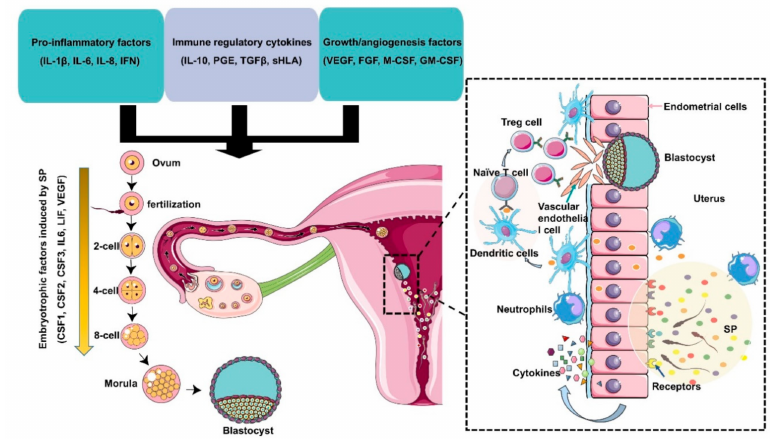
Figure 2. Immunomodulation of SP factors in the maternal reproductive tract to facilitate early embryo development and implantation. Seminal plasma contains chemokines, cytokines, and prostaglandins produced by Leydig and Sertoli cells, seminal vesicles, leukocytes, and other immune cells present in the male reproductive tract. These factors potentially induce inflammation, immunotolerance, and angiogenesis to support embryo development and implantation through the upregulation of embryokines, chemokines, and cytokines from oviductal and uterine tissues. Binding of active moieties in SP to endothelial cells stimulates the recruitment of neutrophils into the uterine tissues, which can clear up excess sperm and seminal debris. Moreover, dendritic cells can recognize paternal major histocompatibility antigens and pass them onto naive T cells and generate an expanded T regulatory (Treg) cell pool in lymph nodes. Since the embryo presents the same paternal antigens in the SP, the response of Tregs to these antigens can be efficiently suppressed, which allows implantation of the semiallogenic embryo into the maternal uterine. On the other hand, Tregs also contribute to endometrial tissue remodeling and receptivity for implantation through the regulation of angiogenesis. SP also results in the production of cytokines and growth factors, such as colony-stimulating factors (CSFs), leukemia inhibitory factor (LIF), and interleukin 6 (IL-6), by the maternal reproductive tract, which are essential for promoting embryo development before implantation. The arrow indicates that embryotrophic factors (CSF1, CSF2, CSF3, IL6, VEGF) are induced by SP during the early embryonic